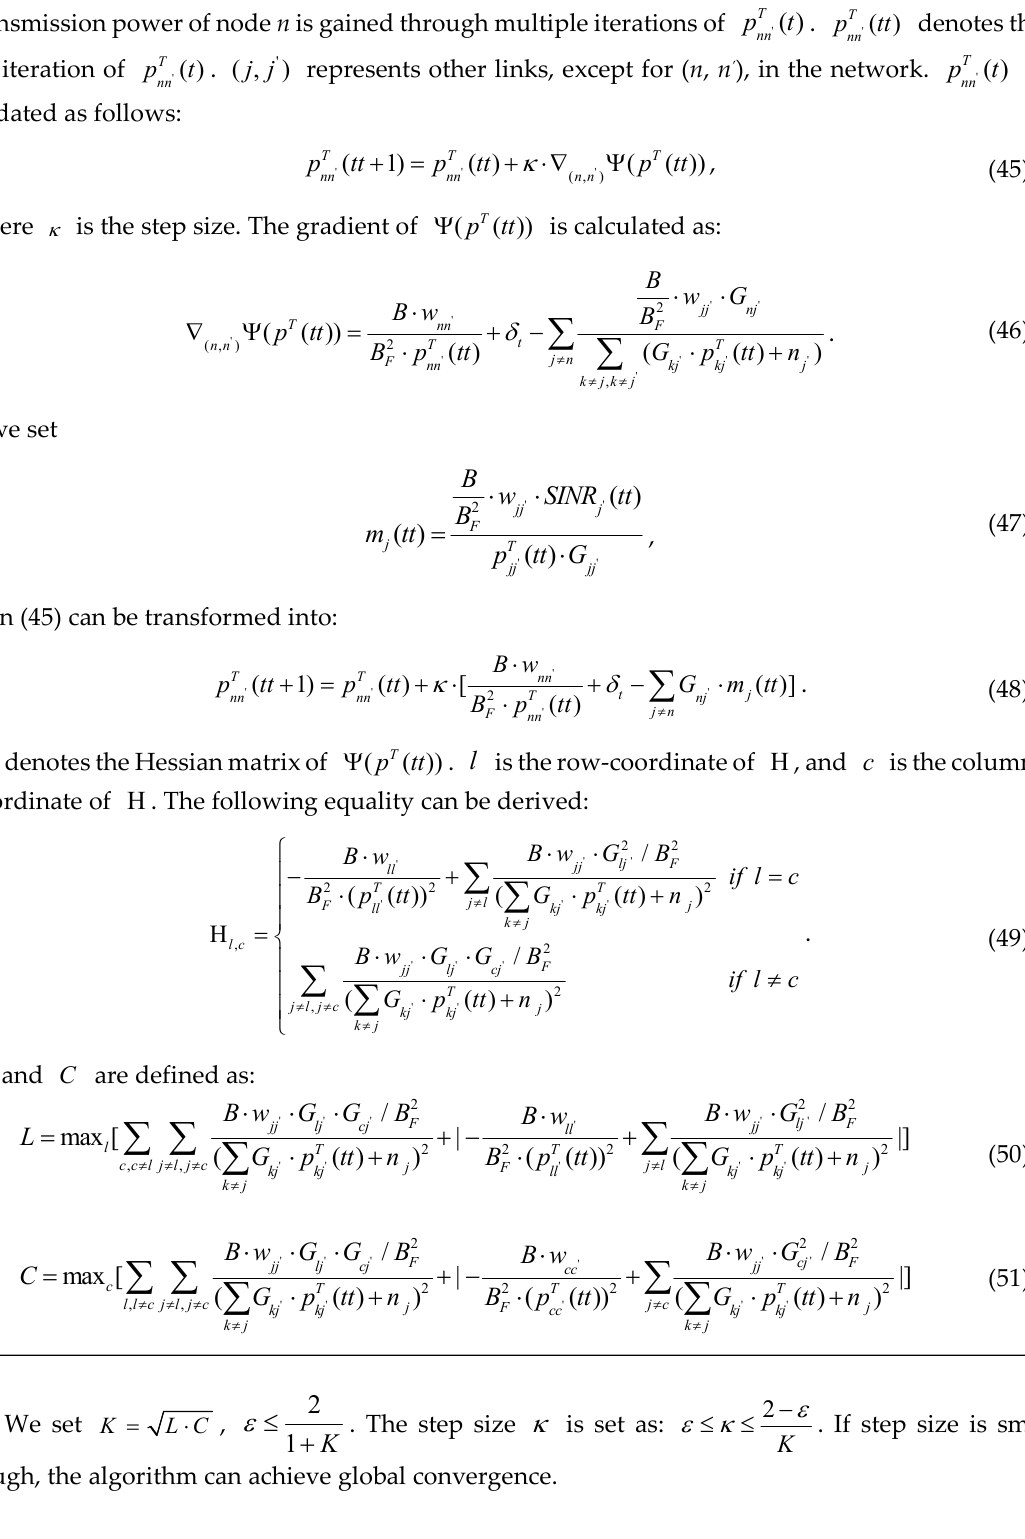
Algorithm 1 (Distributed gradient projection power control algorithm) [49]